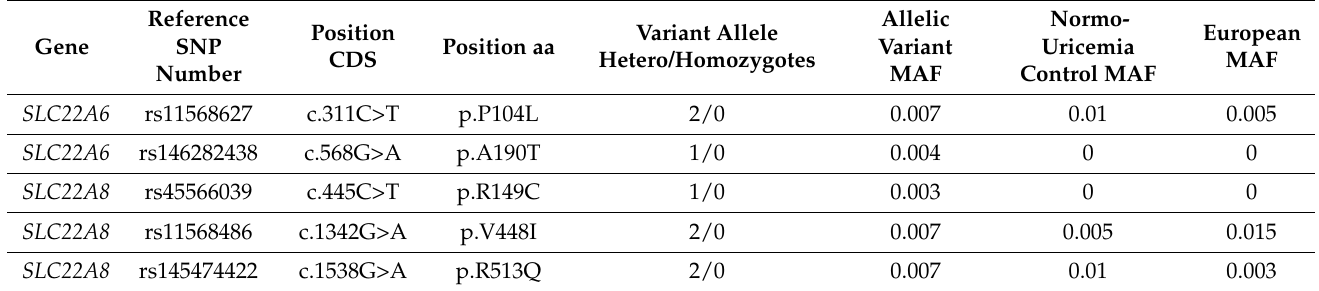
Table 3. Table 3. Non-synonymous allelic variants in SLC22A6 and SLC22A8 were identified in a cohort of 150 patients with primary hyperuricemia and